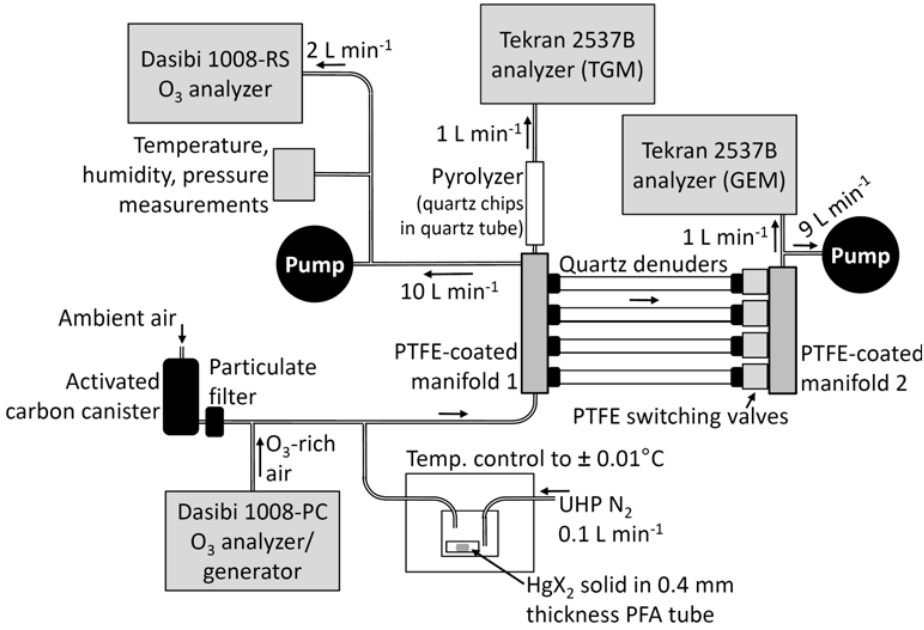
Figure 1. Schematic of sampling system. All sample lines and the manifold upstream of the quartz denuders and pyrolyzer were heated to 100 ◦ C. Sample lines were constructed of 0.64cm PFA tubing. Denuders were connected to manifold 1 via Delrin couplers. The pyrolyzer was heated to 500 ◦ C and denuders were heated to 50 ◦ C. Switching valves allowed only one denuder to sample at a time. Mass flows are shown (STP of 0 ◦ C, 1013mb). The Dasibi 1008-PC was supplied with ambient air that had passed through an activated carbon canister.